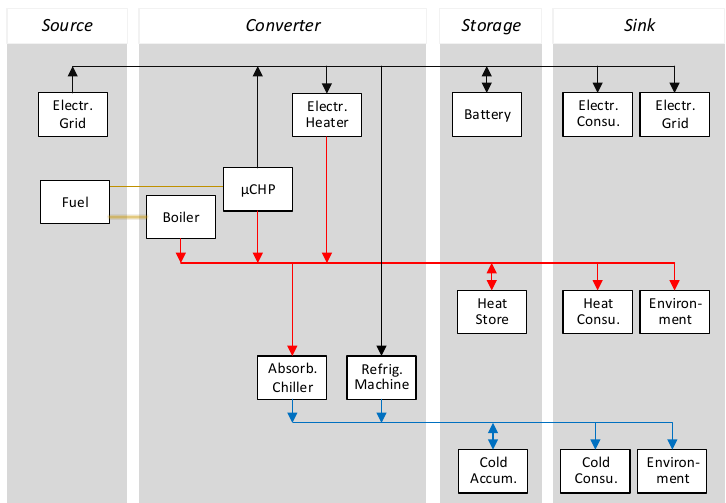
Figure 1. Generic flow chart of stationary SOFC system application with source, converter, storage and sink